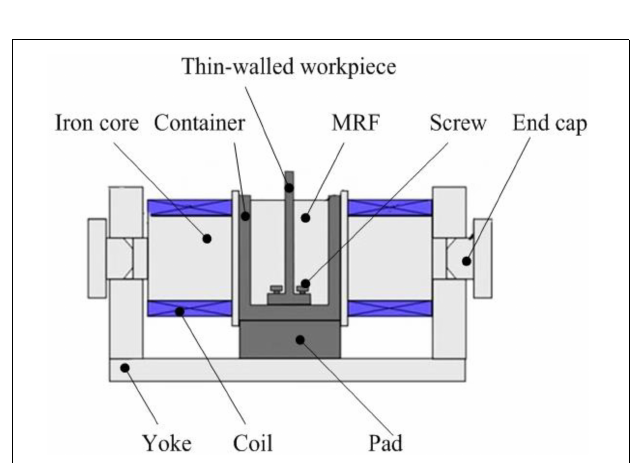
FIGURE 3 | The schematic diagram of a flexible fixture model (Liu H. et al.,